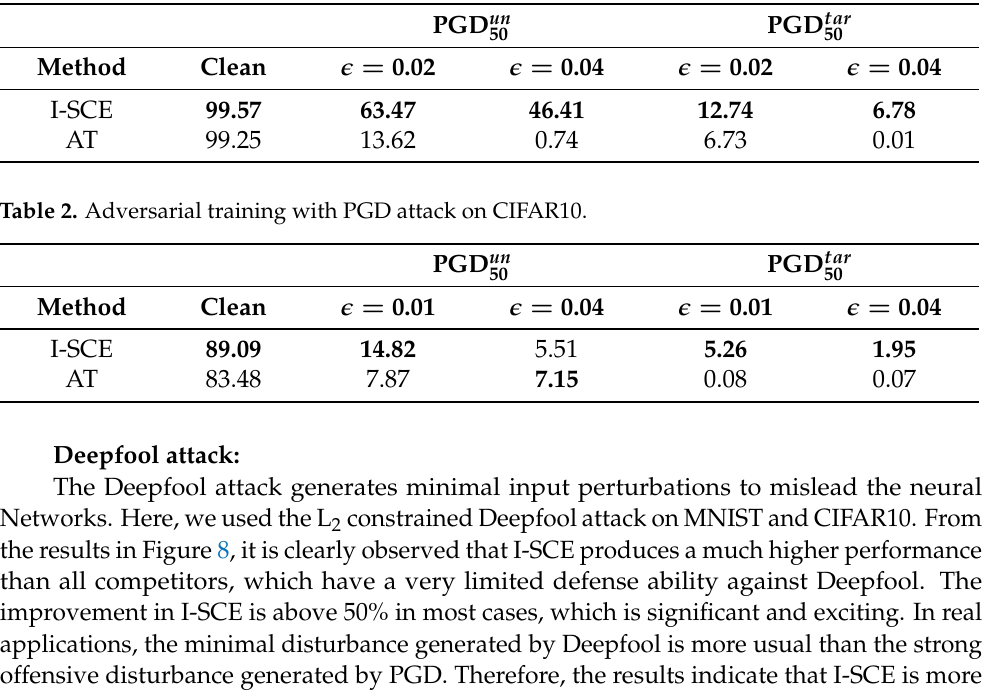
Table 1. Adversarial training with PGD attack on MNIST.